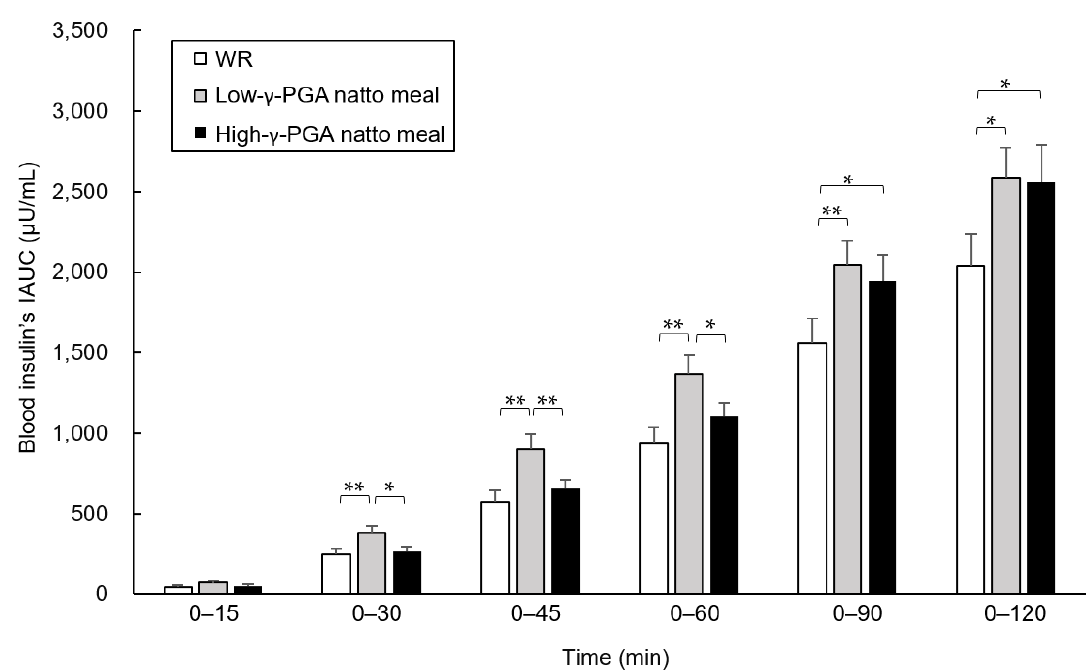
Figure 5. Comparison of the blood insulin’s incremental area under the curve (IAUC) between the test meals at each time point. The blood insulin’s IAUC at 0–15, 0–30, 0–45, 0–60, 0–90, and 0–120 min were compared using a linear mixed model regression analysis with the test meals and groups as fixed e ff ects, and the data are shown as the estimated mean ± the standard error (est. mean ± SE). * p < 0.05, ** p < 0.01. WR: white rice; γ -PGA: gamma-polyglutamic